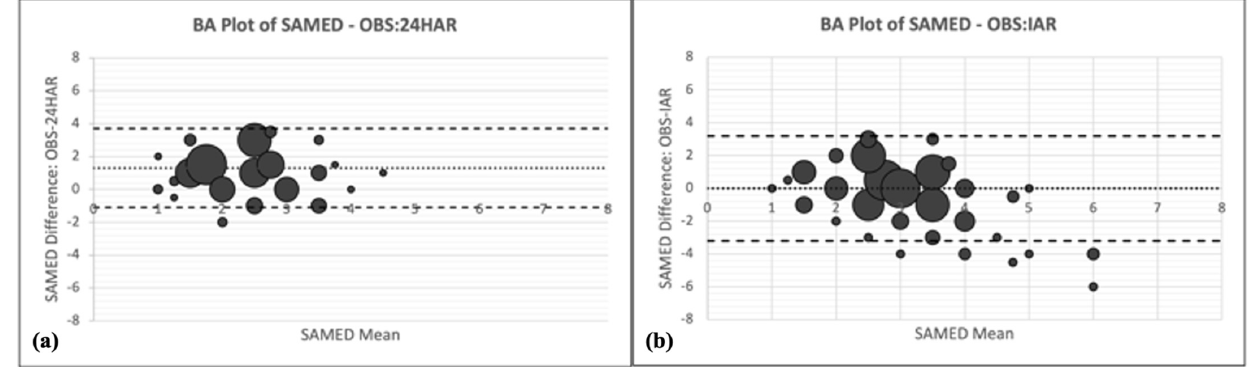
Figure 3. Bland–Altman (BA) plots of time allocation difference versus the mean of observation (OBS) and 24 h recall (24HR) or image ‐ assisted recall (IAR). ( a ) BA plot for concurrent activities ‐ OBS and 24HR, ( b ) BA plot for concurrent activities, OBS and IAR. The dotted line is the mean difference (bias), the long ‐ dashed lines are +/ − 2 SD limits of agreement (LOA). A bias > 0 indicates that 24HR or IAR underestimates time allocation. The size of the point corresponds with the number of households.